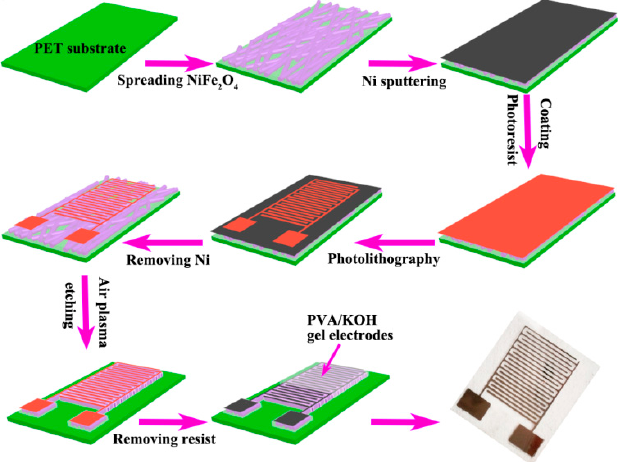
Figure 5. Schematic illustration of the photolithography process for fabricating the flexible on-chip MSCs with NiFe 2 O 4 hollow nanotubes electrodes. The figure has been reproduced with permission from The Royal Society of Chemistry [59].